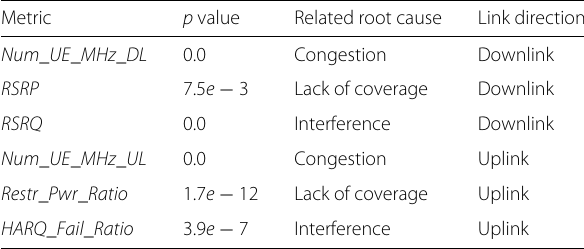
Metric p value Related root cause Link direction